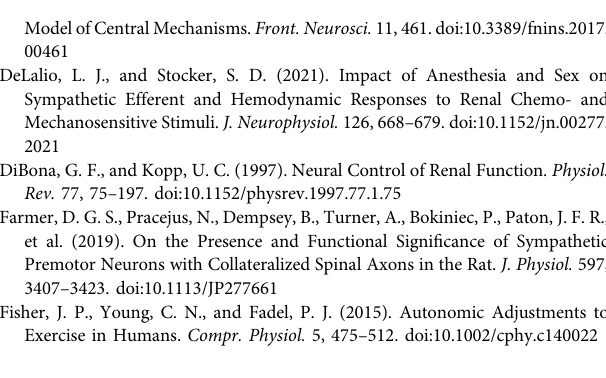
Frontiers in Physiology |